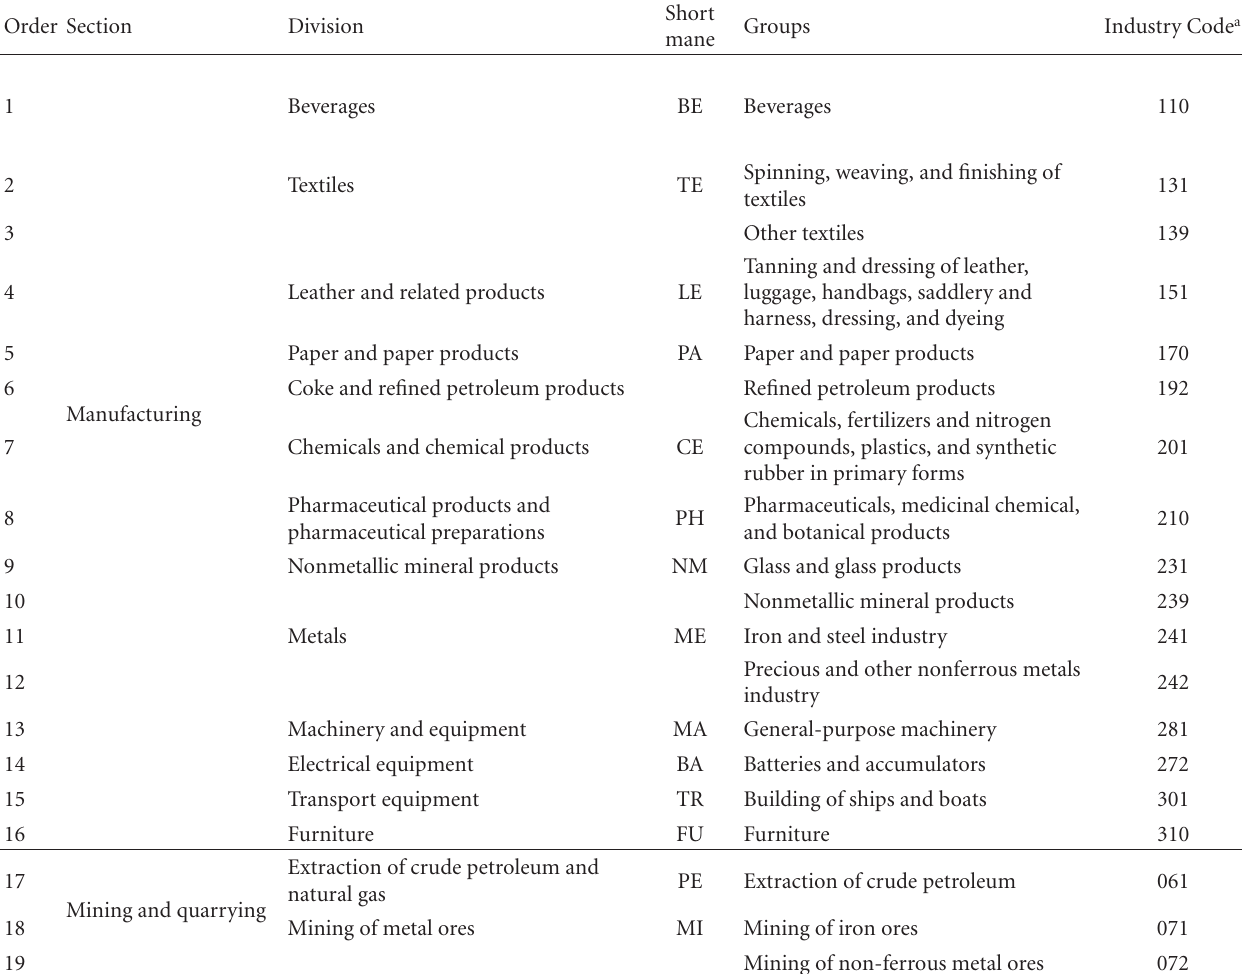
Table 1: Classification of industry types for the analysis of soil metal pollution: the International Standard Industrial Classification (ISIC)